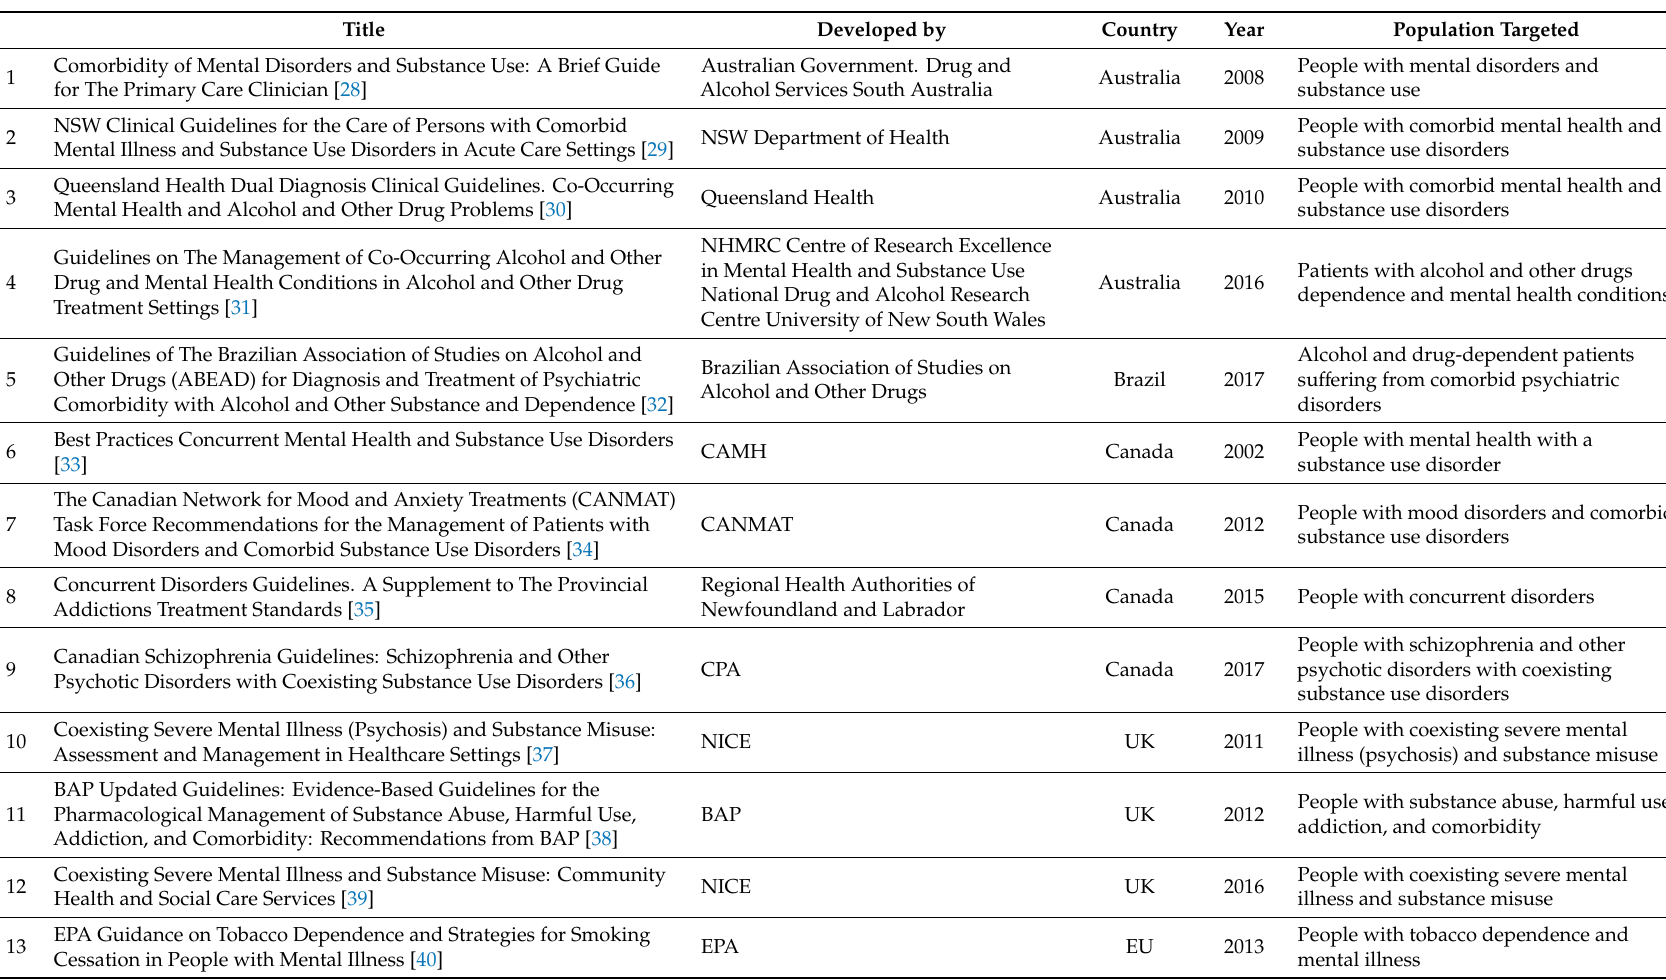
Table 1. Concurrent disorder guidelines included for the appraisal with the AGREE II (Appraisal of Guidelines for Research and Evaluation) tool (last